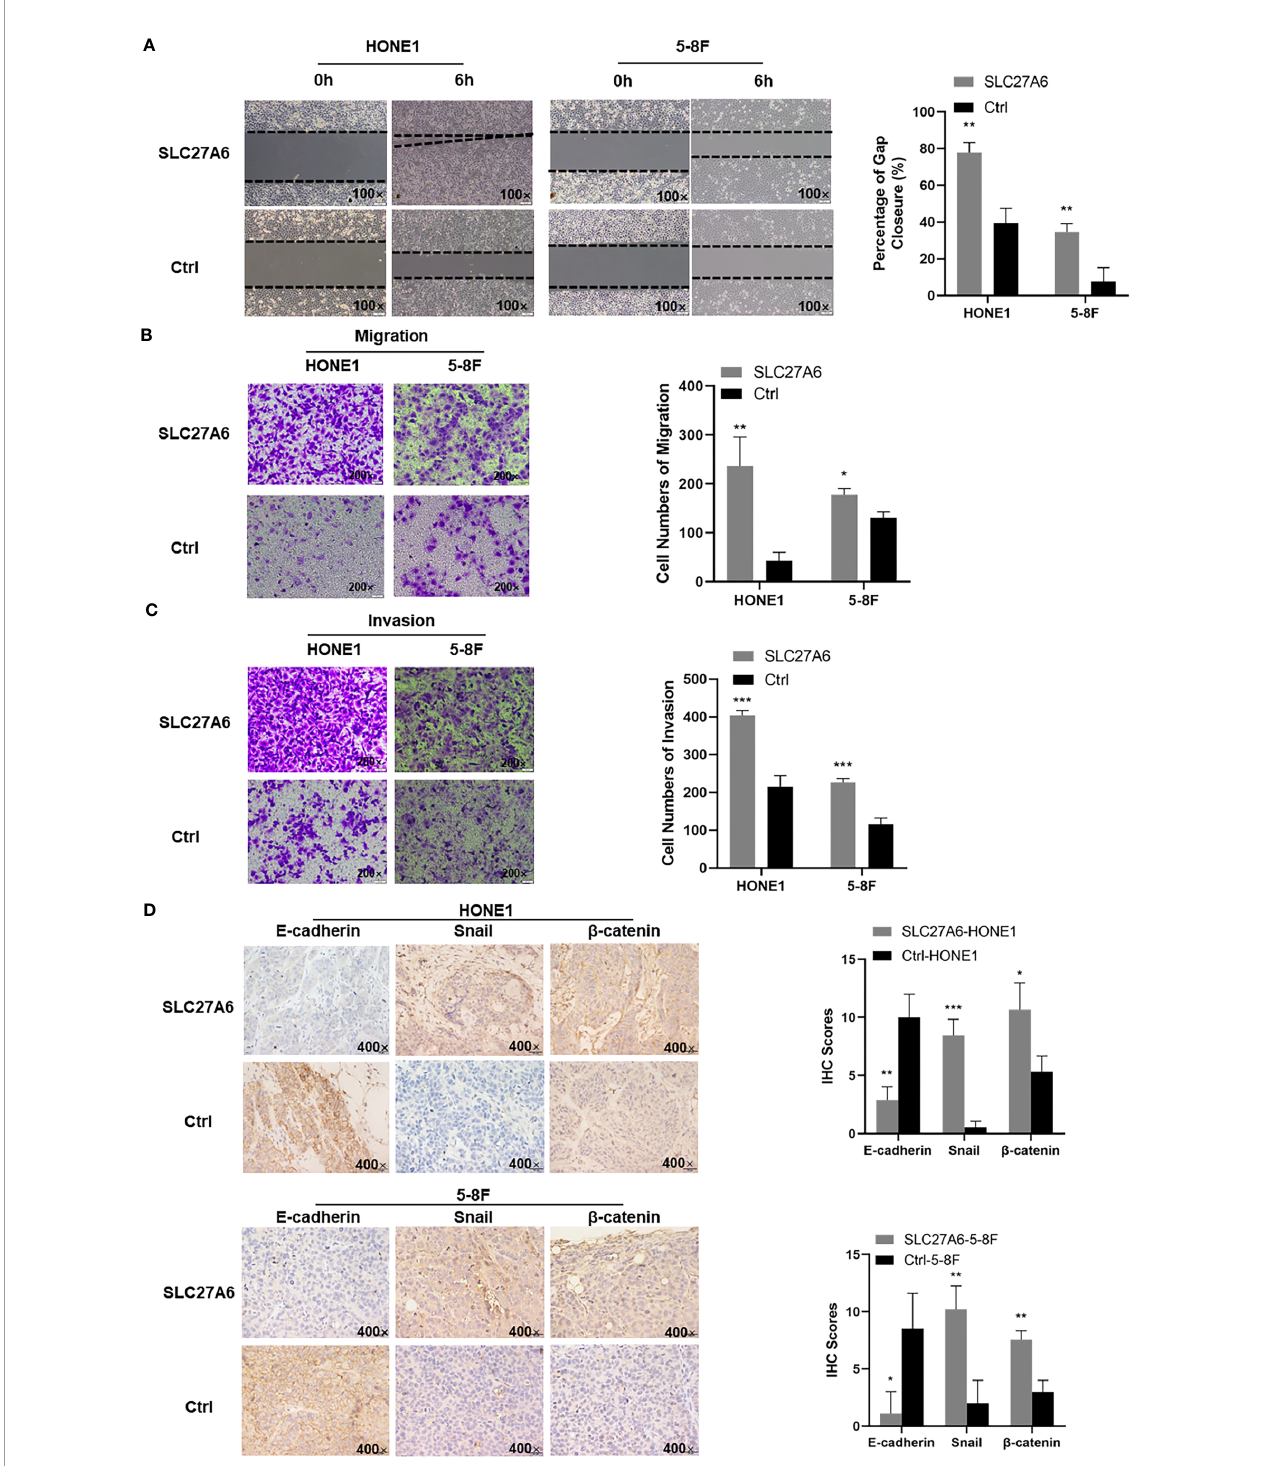
FIGURE 5 | Overexpression of SLC27A6 facilitates the migration, invasion and EMT in NPC cells. (A) Detection of migration in stably transfected NPC cells (HONE1, 5-8F) using a wound-healing assay. Magni fi cation ×100. (B) Migration differences in stably transfected NPC cells (HONE1, 5-8F) by transwell assay. (C) Detection in invasion of stably transfected NPC cells (HONE1, 5-8F) using transwell assay (gel-coated). Magni fi cation ×200. (D) IHC staining of the EMT signals (E-cadherin, Snail and b -catenin) in xenograft tumor. Magni fi cations ×400. *P < 0.05; **P < 0.01; ***P <